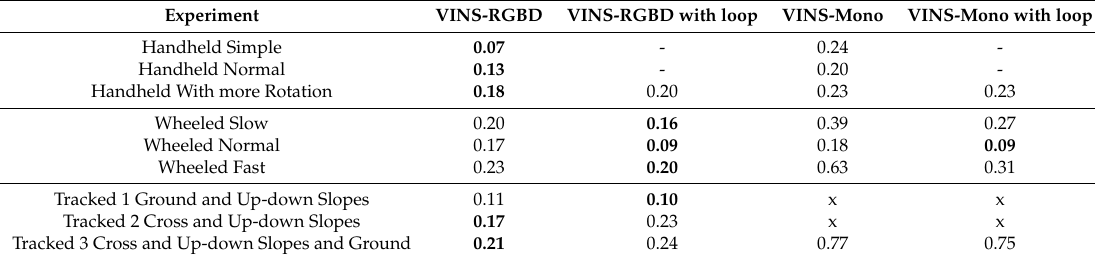
Table 1. RMSE of three different experiments in meters. “-” denotes no loop, “x” denotes test